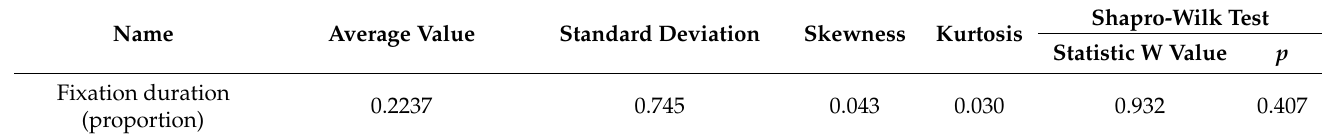
Table 10. Data normality test for different styles of button fixation duration.